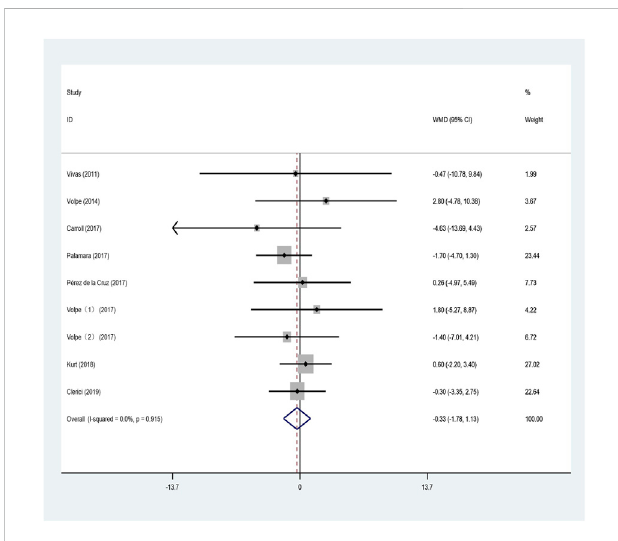
FIGURE 5 In fl uence of aquatic exercise on motor function of PD patients.